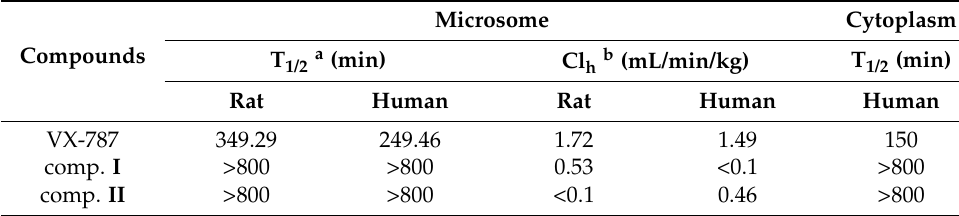
Table 2. Mean pharmacokinetic parameters of VX-787 and comp. I / II in liver cytoplasms or micro- somes of two species (human/rat). Metabolic stability assay using mouse liver microsomes.